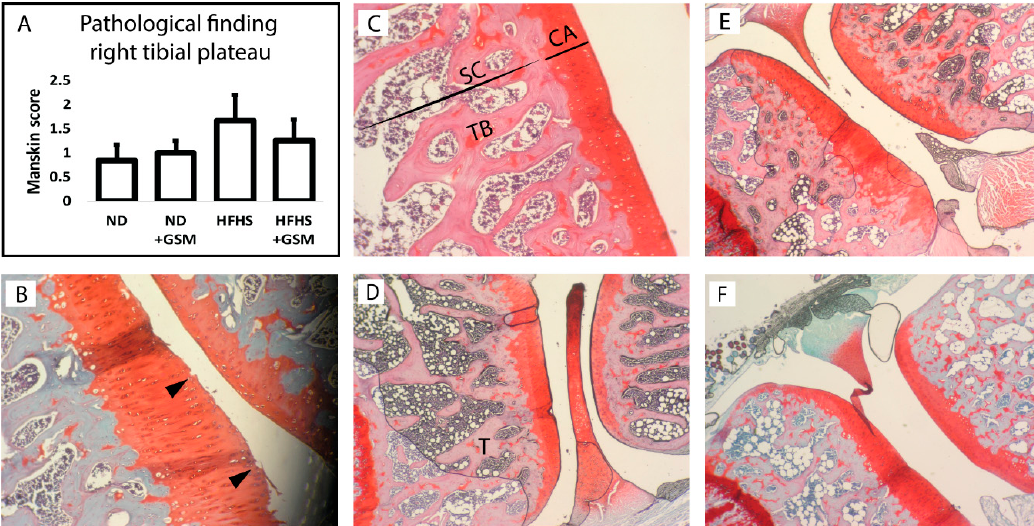
Figure 3. ( A ): Histopathological assessment of osteoarthritis in right knee joints: Mankin score was used to measure the severity of osteoarthritis at the tibial plateau. Scores for each histological aspect were summed for each individual. Data are shown as mean + standard error of mean of n = 11–12 rats per diet group. No significant difference was detected by analyzing with the Mann–Whitney U test. Knee joint at microscopic levels, 40 and 100× magnification: Articular cartilage of tibia bone (T) from each group, ND ( C ), ND + GSM ( D ), HFHS ( E ), and HFHS + GSM ( F ). Dark red staining represents cartilaginous layers (CA), which have similarity in color and thickness across all groups. Most of the slices have smooth surface cartilage and seem to be normal articular cartilage. Surface irregularities were found in some tissue samples from HFHS as indicated by black arrowheads ( B ). SC = subchondral bone, TB = trabecular bone.